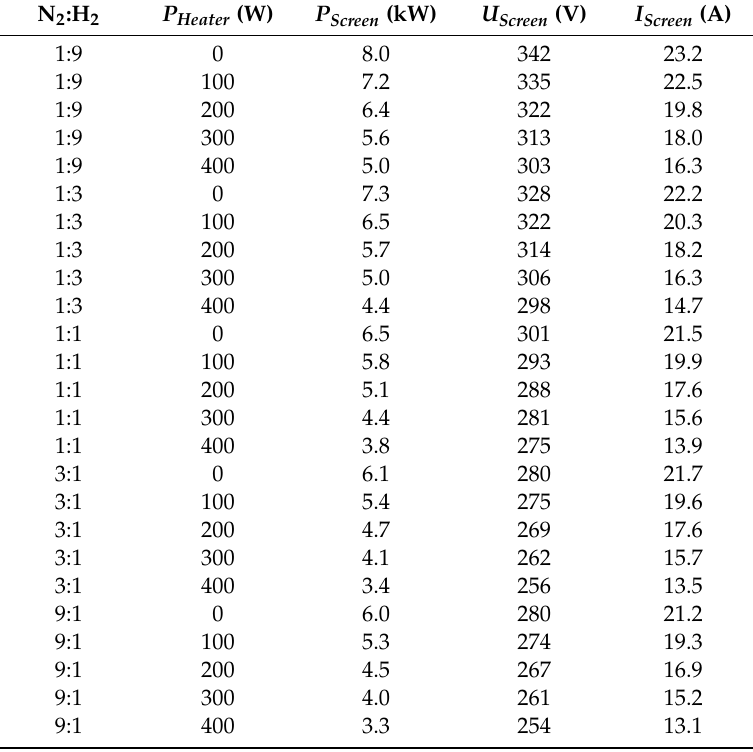
Table 1. Average electrical parameters for ASPNC experiments for material treatment and spectroscopic